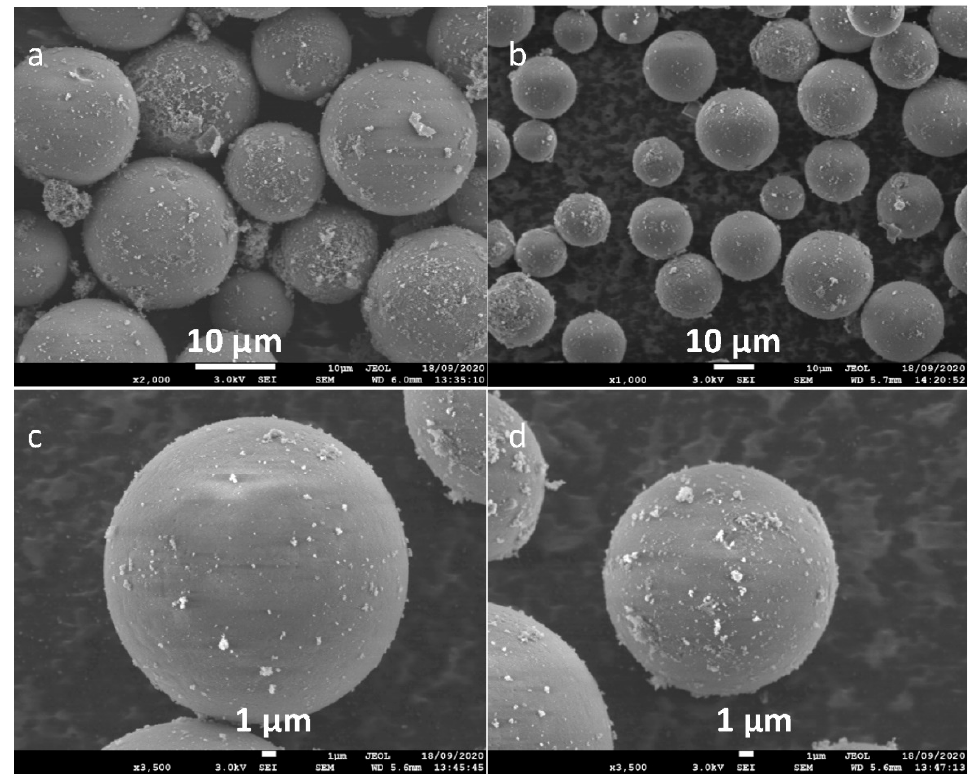
Figure 3. SEM images showing unfunctionalised flash and HPLC silica at ( a ) 10 and ( c ) 1 μ m magnification, respectively; and flash and HPLC silica functionalised with C -butylpyrogallol[4]arene stationary phase particles at ( b ) 10 and ( d ) 1 μ m magnification, respectively.